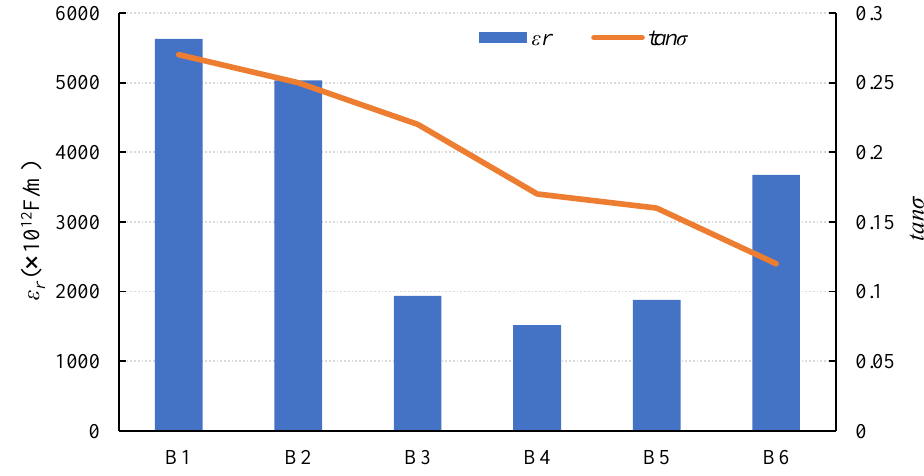
Figure 9. Changes in dielectric properties with modulus. Table 8. Changes in C with modulus.